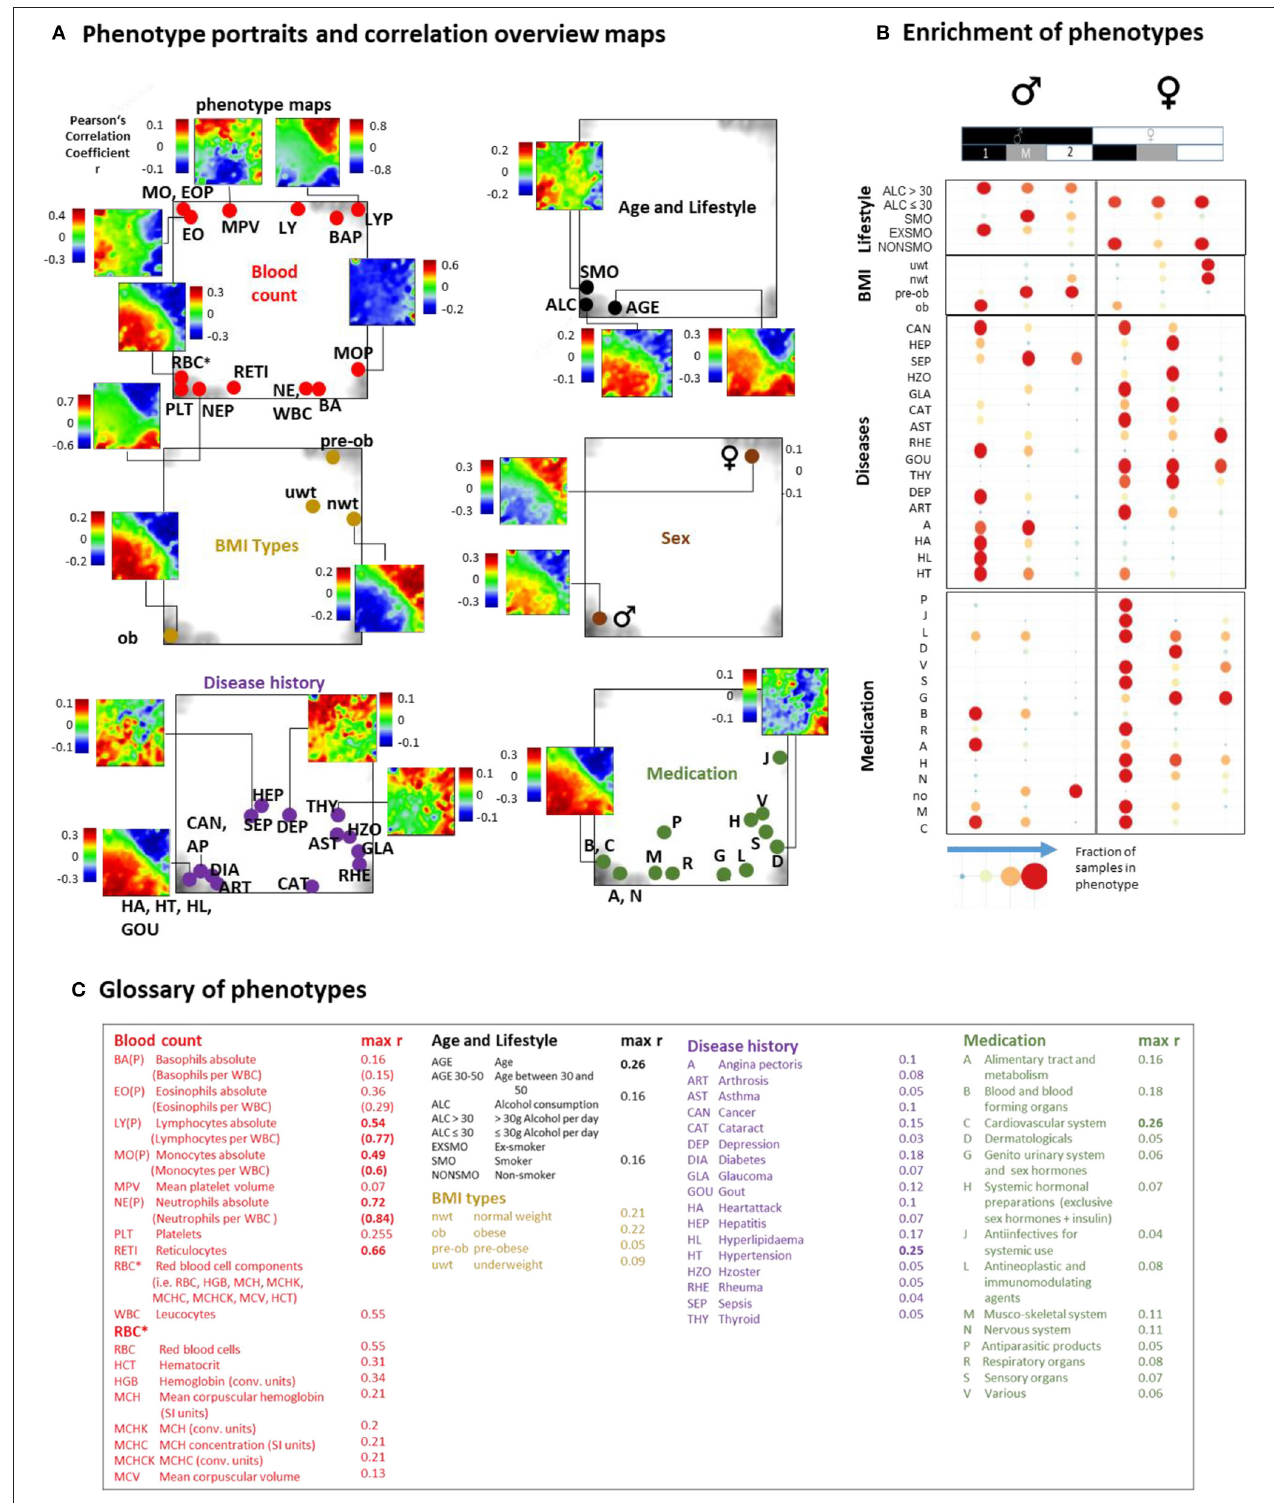
FIGURE 5 | Association of selected features (phenotypes) with the transcriptome landscape of blood: (A) Phenotype (correlation) portraits visualize the correlation between metagene expression profiles and the profiles of selected phenotypes in a red-to-blue color scale. The correlation overview maps for each of the categories mark the metagene of maximum correlation coefficient for each of the phenotypes studied [see the legend in (C) and also Table S 1 for assignment of phenotypes].